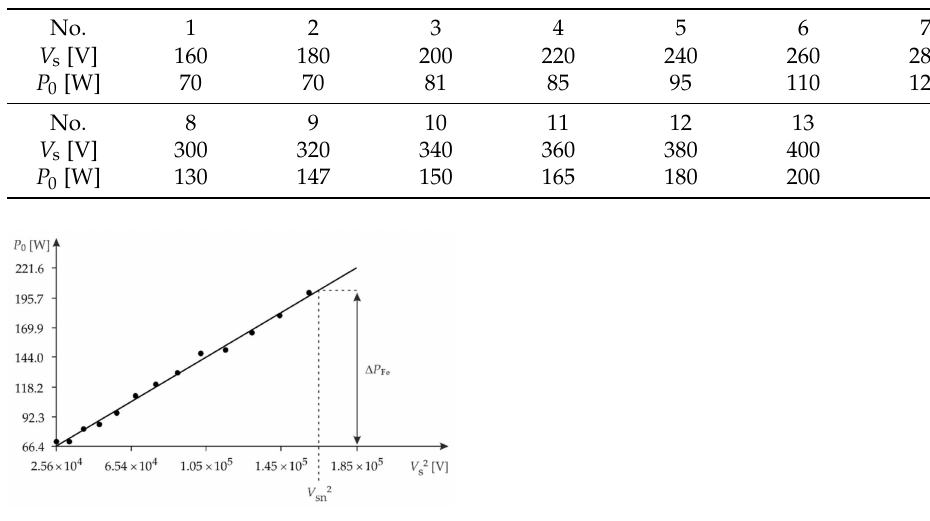
Figure 6. Results for the power loss in the stator iron ∆ P Fe .